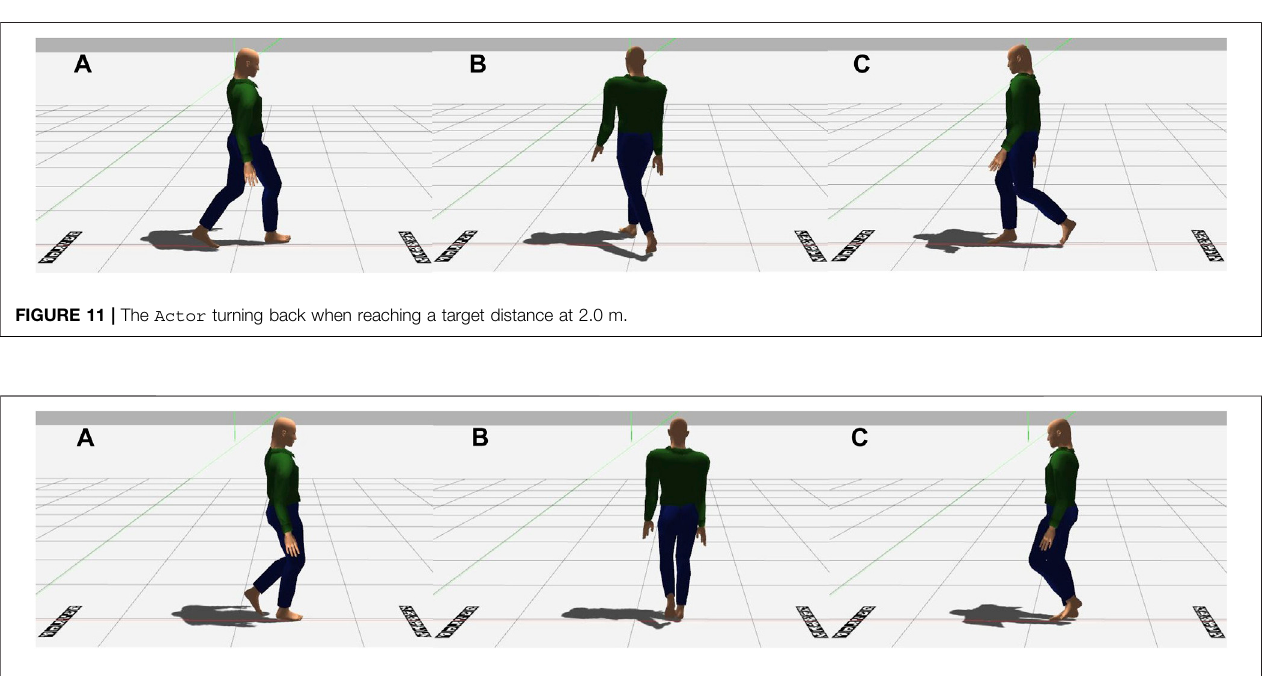
FIGURE 12 | The Actor turning back when reaching a target distance at 2.3 m.